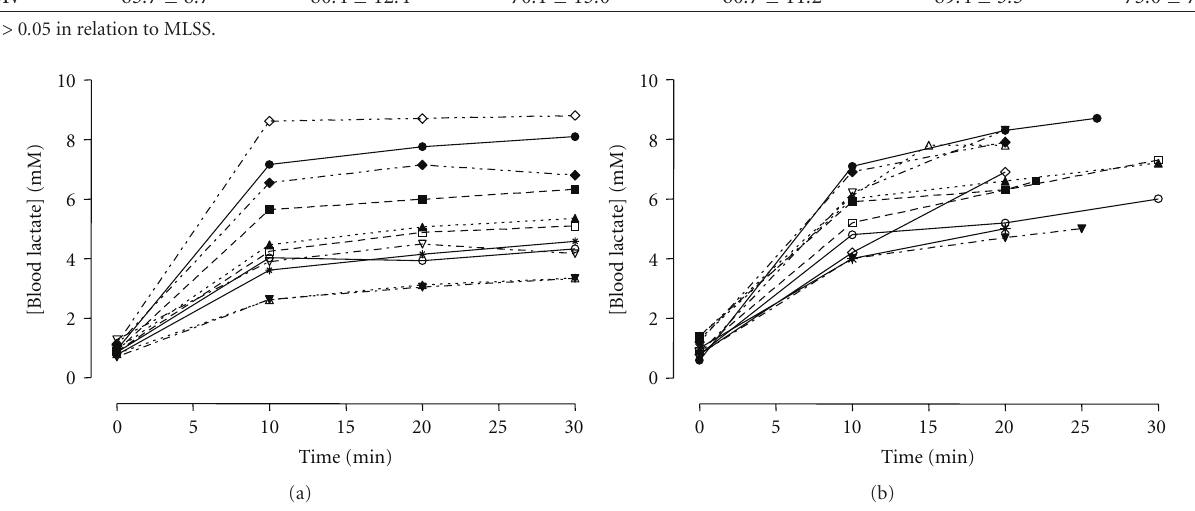
Figure 4: Blood lactate concentrations from all subjects during the 30-min constant test at MLSS intensity (a) and at the intensity 1% above the MLSS